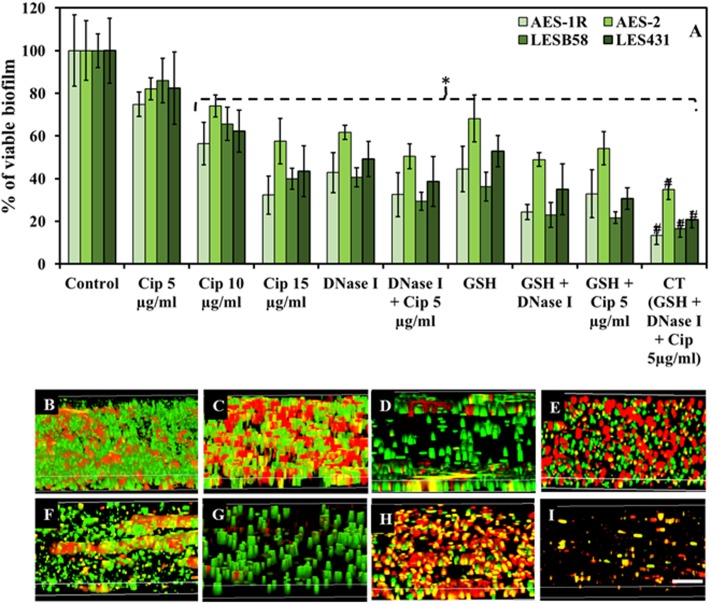
Effect of GSH, DNase I, ciprofloxacin and combination therapy (CT) on P. aeruginosa biofilm. (A) The resazurin bacterial viability assay showed effect of ciprofloxacin, GSH, DNase I and combination treatment on 48 h old established biofilms of different P. aeruginosa CF isolates grown in LB media. All isolates showed significant decrease in bacterial viability when treated with ciprofloxacin (Cip) at the highest concentrations (10 and 15 μg/mL). Conversely, DNase I or GSH-alone treatment and in combination with low Cip concentration (5 μg/mL), resulted in a significant decrease in P. aeruginosa viability. The most significant decrease in bacterial viability was observed with biofilms subjected to all three components of the CT GSH + DNase + Cip 5 μg/ml. (B–I) Confocal microscopy imaging showing the effect of ciprofloxacin, GSH, DNase I and GSH-combination treatment, on 48 h old established biofilms of AES-1R grown in ASMDM. With untreated AES-1R biofilm (B), ciprofloxacin alone did not disrupt the biofilm but showed an increase in red-staining (dead) cells (C). Disruption of the biofilm architecture of AES-1R was observed when it was treated with DNase I (D) or DNase I combined with ciprofloxacin (E). Similarly, GSH alone (F) and in combination with either DNase I (G), or ciprofloxacin (H), increased biofilm disruption and dead bacterial cells. Combination therapy (GSH + DNase I + Cip 5 μg/mL) resulted in complete disruption of the biofilm (I). Scale bar = 50 μm. (A)
∗P < 0.05 when compared to control. #P < 0.005 when compared to all treatments. Data represent mean ± SD; n = 3 experiments performed in biological replicate.